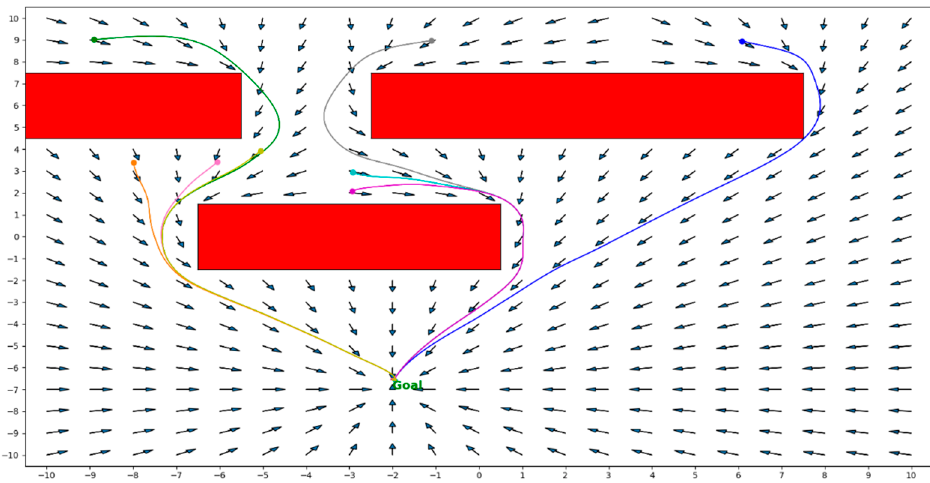
Figure 15. Sample trajectories after DRL fine-tuning.